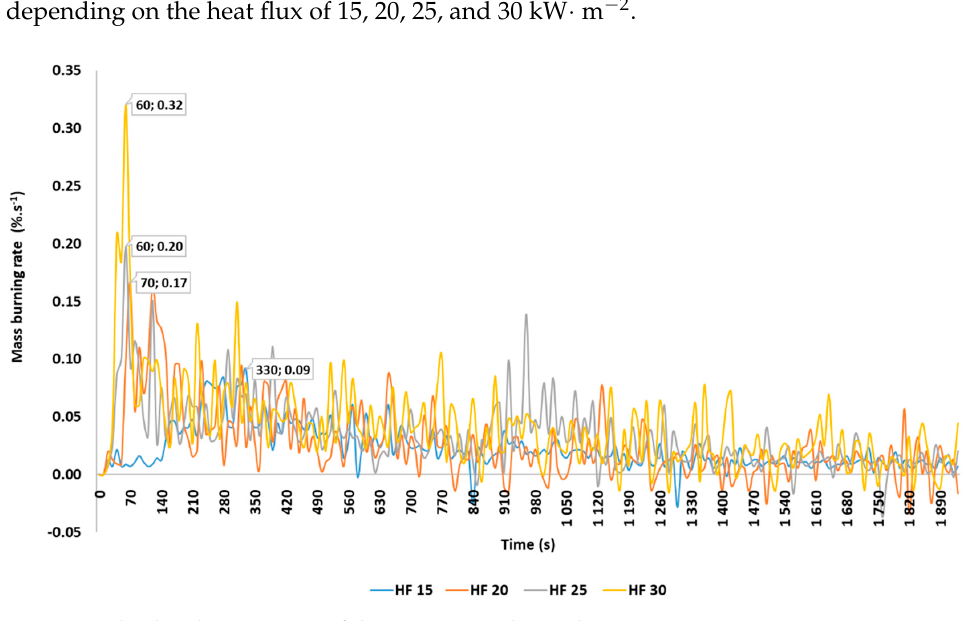
Figure 1. Absolute burning rate of the spruce wood samples. Burning rate of spruce wood samples is calculated based on weight losses in time interval up to 1920